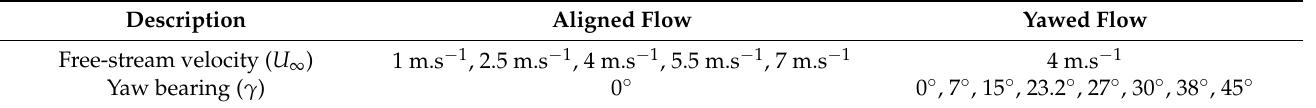
Table 2. Domain model